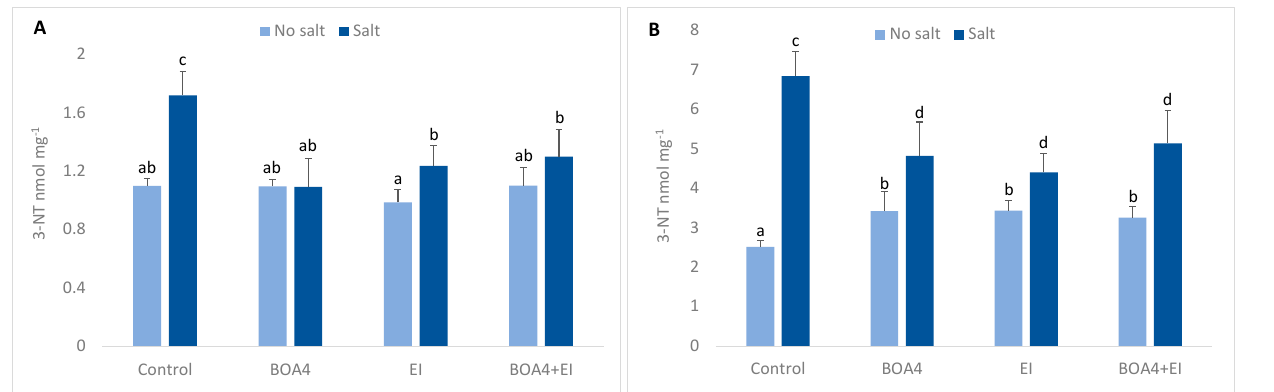
Figure 5. Nitrotyrosine (3-NT) content of tomato plants is represented for the different treatments. Panel ( A ) shows shoots 3-NT content and panel ( B ) roots 3-NT content. No-salt and salt stress conditions are represented by light-colored and dark-colored columns, respectively. BOA4: Achromobacter xylosoxidans strain BOA4; EI: Enteromorpha intestinalis extract; BOA4 + EI: Achromobacter xylosoxidans strain BOA4 plus Enteromorpha intestinalis extract. Bars represent standard deviation. Different letters above the bars indicate means that differ significantly ( p < 0.001).